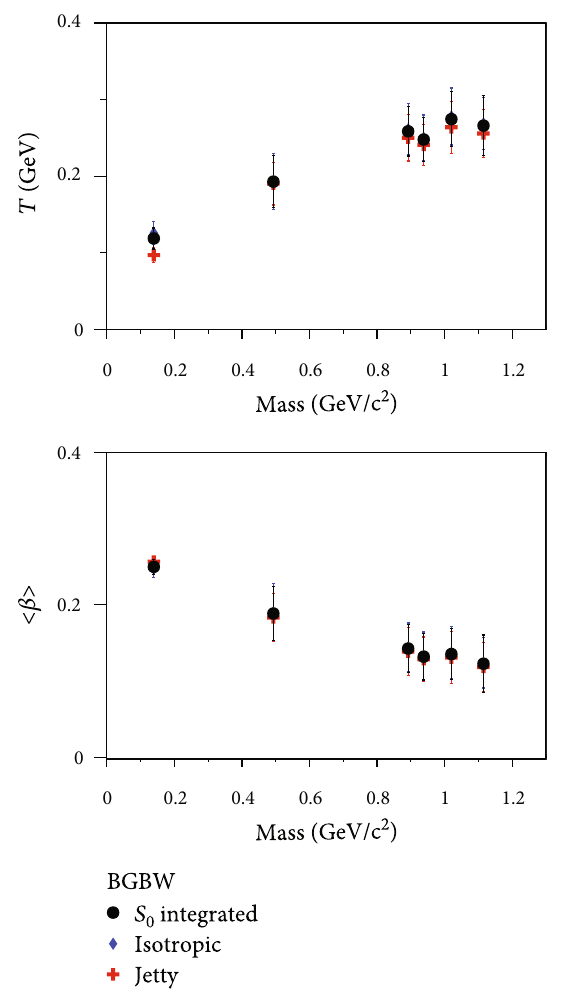
Figure 17: (Color online) Mass dependence of T and h β i in di ff erent spherocity classes for the highest multiplicity class using ~ 2 BGBW fi t up to p T